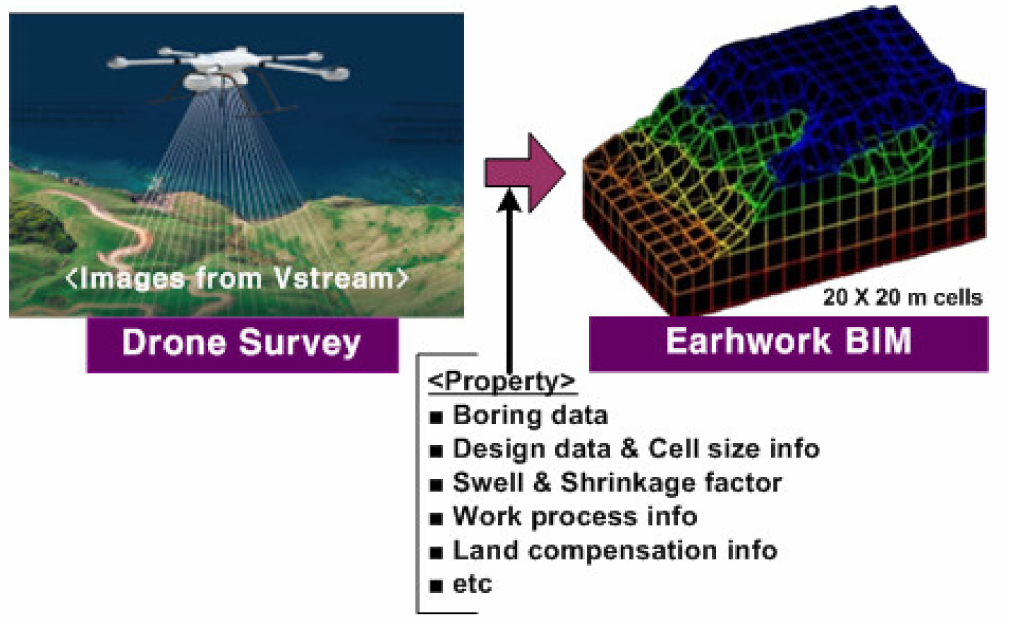
Figure 1. Earthwork BIM